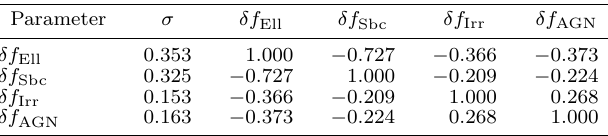
Table 6 Covariance Matrix of Red SED